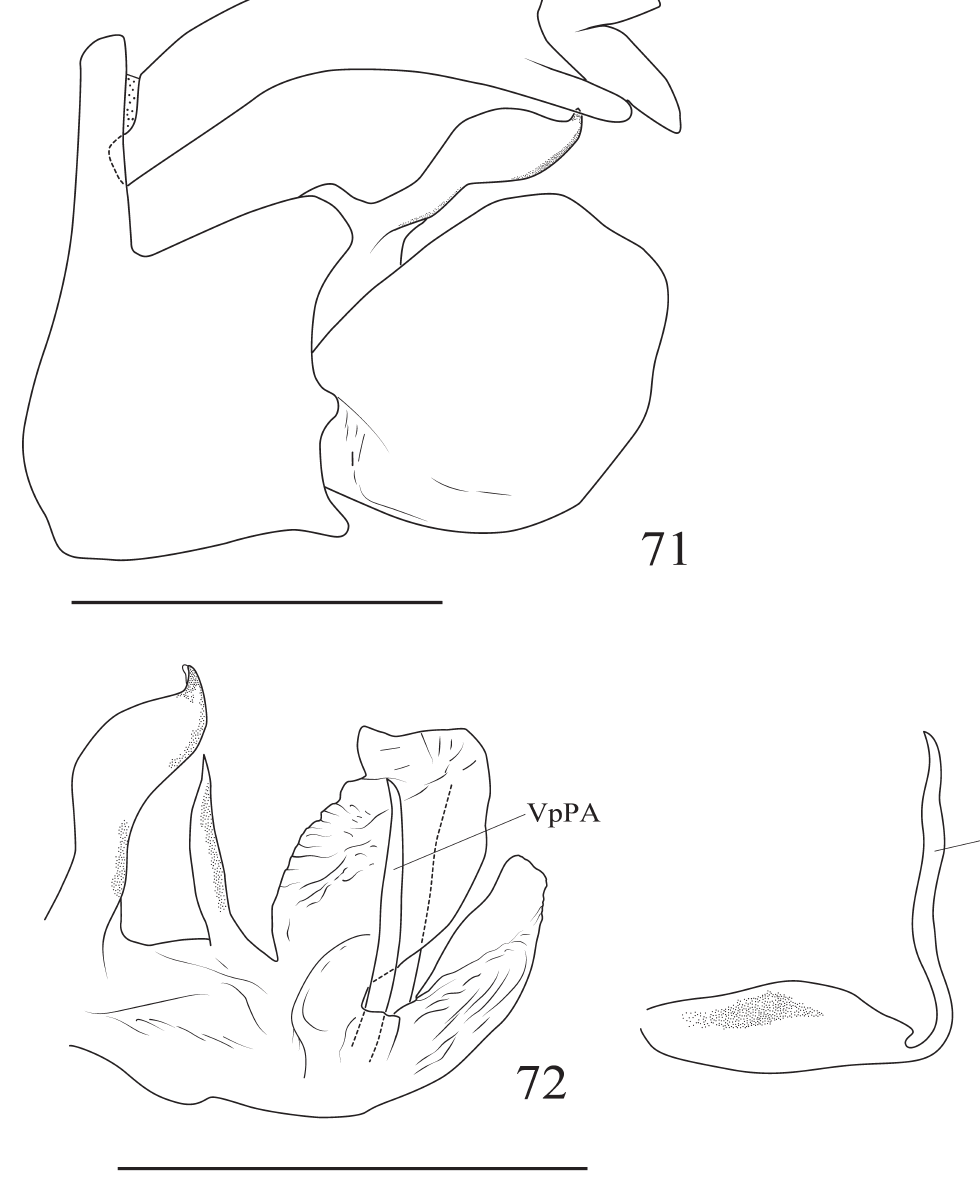
Figs 71–73. Lacusa yunnanensis Chou & Huang, 1985 stat. rev., from Thailand, Chiangmai Province. 71 . Male terminalia, lateral view. 72 . Phallic complex: periandrium and aedeagus, lateral view. 73 . Aedeagus, lateral view. Scale bars = 1